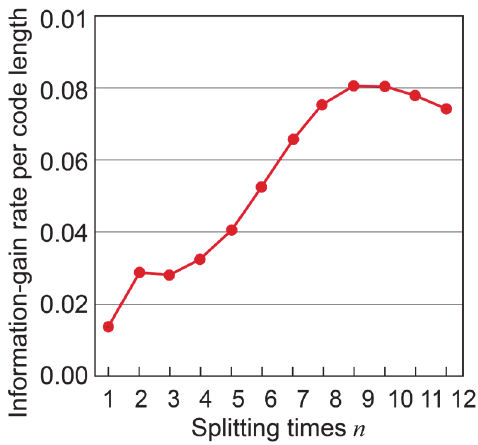
Figure 6 . Information-gain rate per code